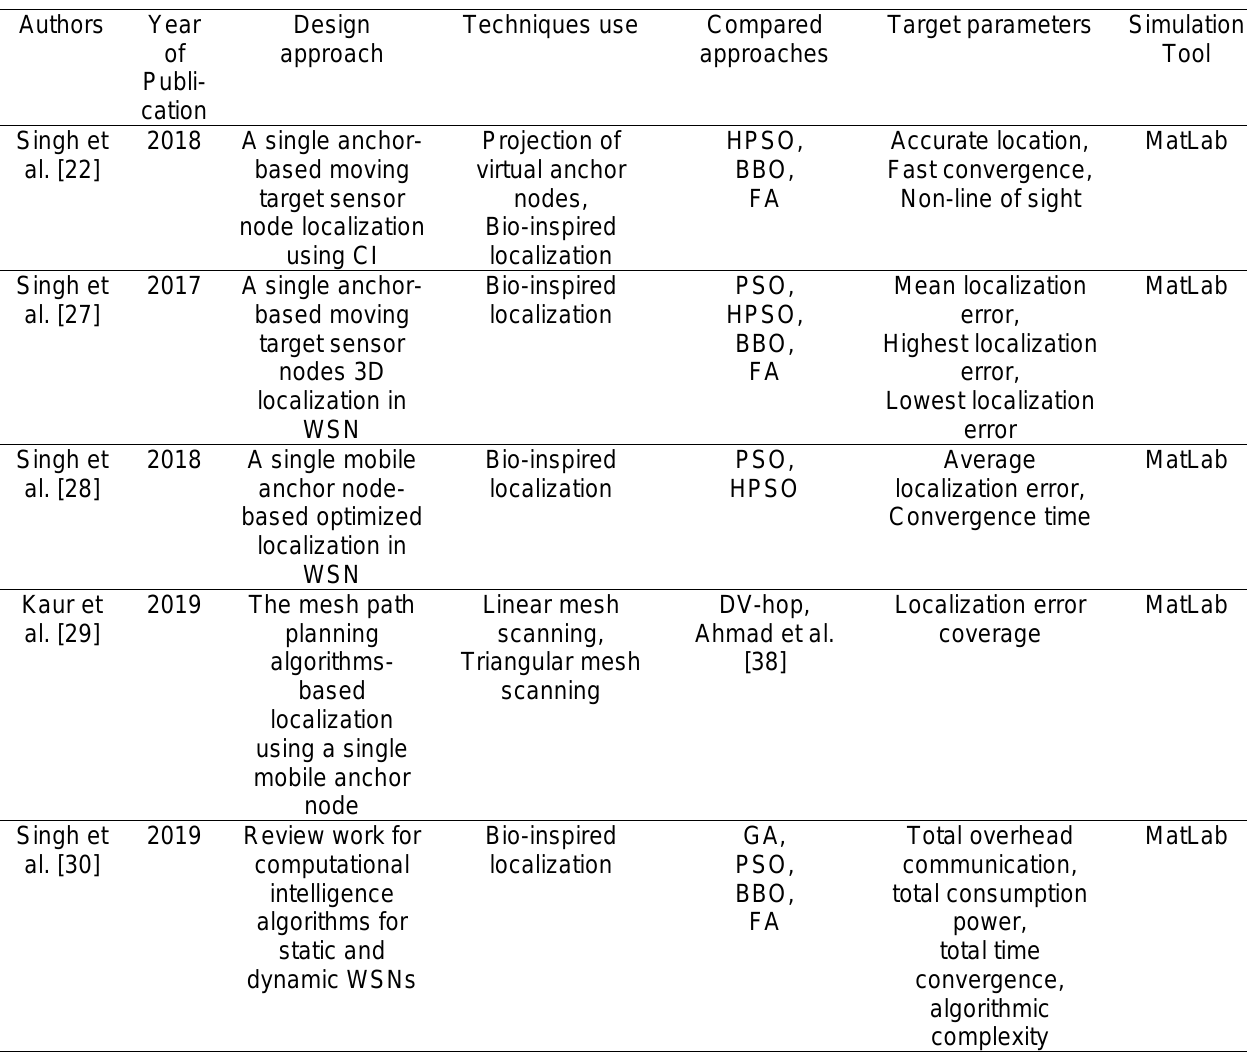
Table 2. Taxonomy of single beacon-based localization approaches using computational intelligence algorithms for sensor nodes in